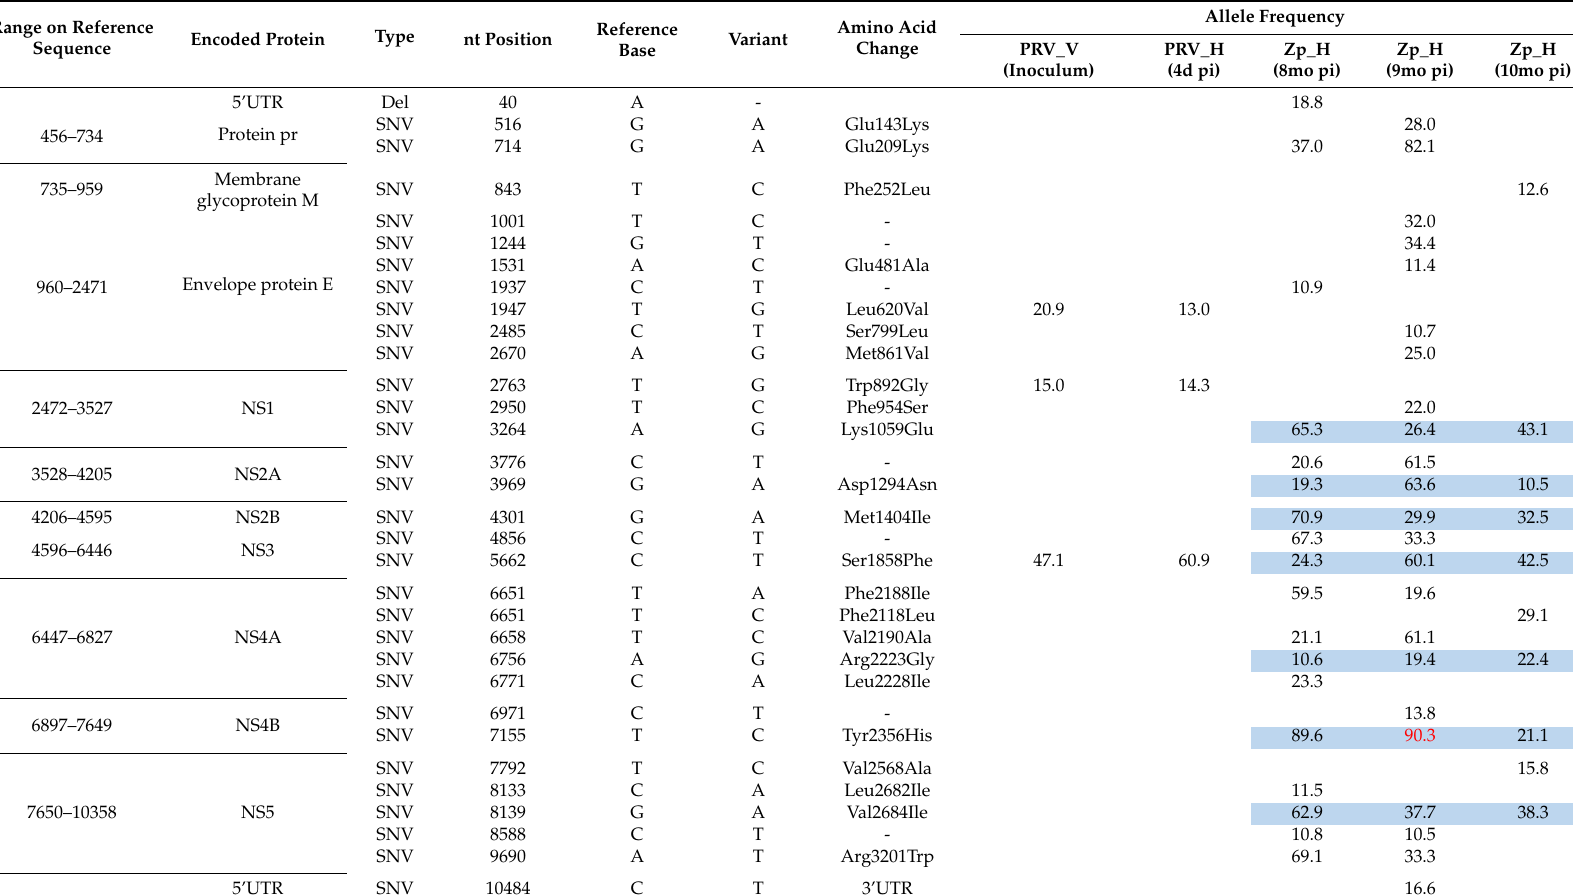
Table 1. Summary of ZIKV RNA genomic variants bearing sequence changes in structural proteins identified in the inoculum PRV ZIKV and ZIKVs produced by acutely and persistently PRV ZIKV-infected HEK293 cells on the structural protein genes in comparison with the reported PRV reference genomic sequence. Range on Reference